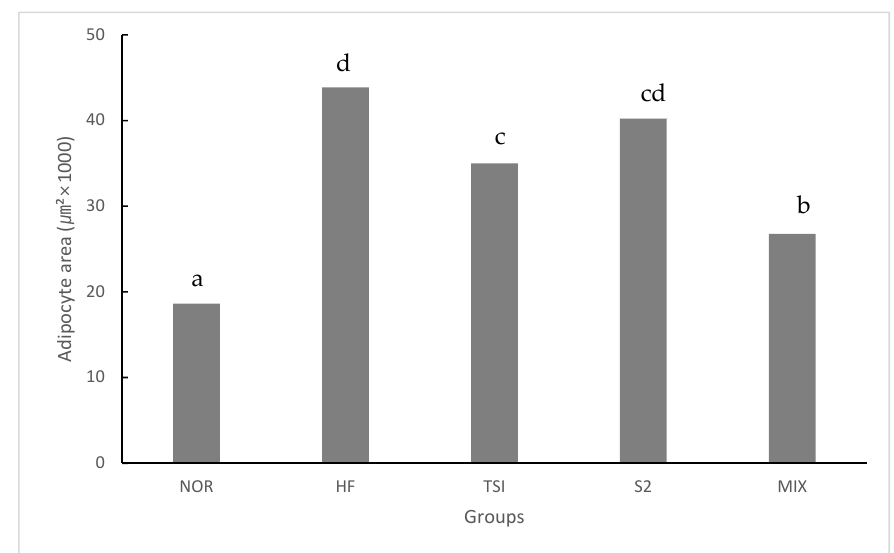
Figure 3. Adipocyte size in abnormal adipose tissue in SD rats on an experimental diet for 8 weeks. NOR, normal diet control fed with AIN-93G and treated with oral saline; HF, 45% high-fat diet- fed control treated with oral saline; TSI, 45% high-fat diet fed and orally treated with yogurt fermented by Lactobacillus fermentum TSI; S2, 45% high-fat diet fed and orally treated with yogurt fermented by L. fermentum S2; MIX, 45% high-fat diet fed and orally treated with yogurt fermented by L.fermentum TSI and L. fermentum S2 mixed culture. HD-fed groups presented a significantly greater adipocyte size than those administered a normal diet ( p < 0.05). Accordingly, the TSI and MIX groups presented significantly smaller adipocytes than the HF group. Adipocyte tissue growth occurs via hyperplasia and hypertrophy. Furthermore, a reduction in the adipocyte size prevents hyperplasia and hypertrophy because of an increase in adipocyte-stimulating factors triggering adipogenesis via preadipocyte differentiation [37]. The quality characteristics of yogurt fermented by LAB species derived from a Mongolian fermented milk product including L. fermentum TSI and L. fermentum S2 were found to be suitable for commercialization. The fermentation was confirmed to be well-processed because the pH values were within the optimum pH range of fermented milk on the market. In all groups, the number of LAB was over 7 log CFU/g, thus meeting the minimum requirement for fermented food products. The yogurt prevented obesity by decreasing the adipocyte size in the abdominal fat tissue of HD- induced obese rats. In particular, yogurt obtained from L. fermentum TSI decreased the abdominal fat and improved serum HDL-cholesterol levels and adiponectin secretion. However, the synergistic effect of the combination of two strains remains unclear. Therefore, dairy products fermented by L. fermentum TSI, isolated from Mongolian traditional dairy products, may be a functional probiotic in improving blood cholesterol and body fat accumulation. Author Contributions: These authors (W.-Y.C. and G.-E.H.) contributed equally to this study. Data curation, W.-Y.C., G.-E.H. and H.-J.L.; Formal analysis, W.-Y.C., H.-J.L. and S.-J.Y.; Investigation, W.-Y.C., G.-E.H. and S.- J.Y.; Methodology, W.-Y.C., G.-E.H., H.-J.L., S.-J.Y. and Y.Z.H.; Resources, H.-D.P.; Software, G.-E.H.; Supervision, C.-H.L., Writing—original draft, W.-Y.C. and G.-E.H.; Writing—review & editing, W.-Y.C. All authors have read and agreed to the published version of the manuscript. Funding: This study was supported by National Research Foundation of Korea Grant funded by the Korean Government [NRF-2014K1A3A1A08045094].